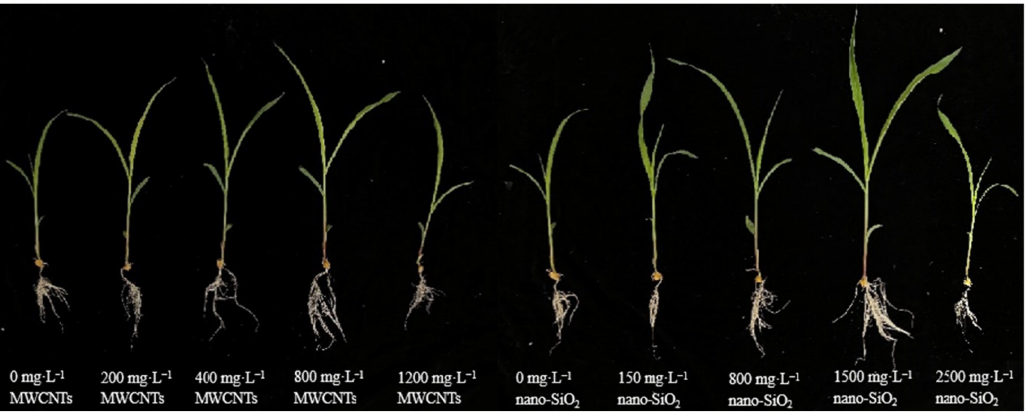
Figure 1. Effect of different concentrations of MWCNTs and nano-SiO 2 on maize seedling